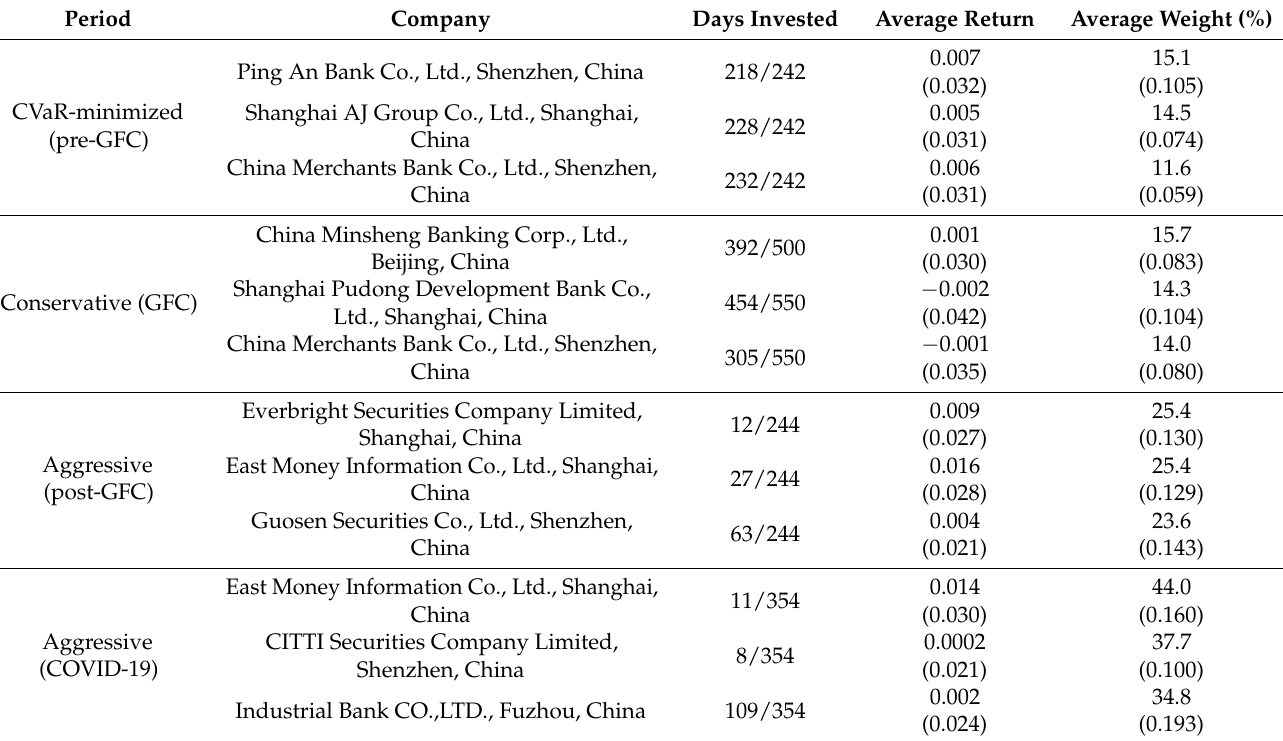
Table 2. Financial institutions with the largest weights in the best strategies.